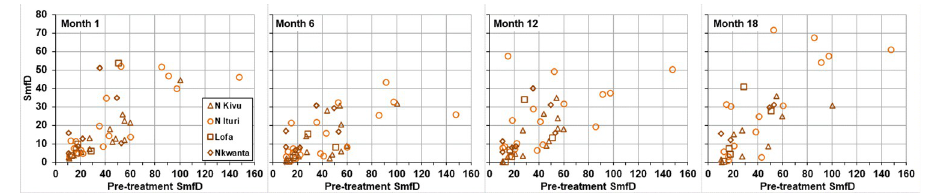
Fig 7. SmfD 1, 6, 12 and 18 month post-treatment in participants with ‘suboptimal microfilariae response’ to ivermectin as indicated by � 80% reduction of skin microfilariae levels from pre-treatment to 1 month after treatment’. SmfD: skin microfilariae